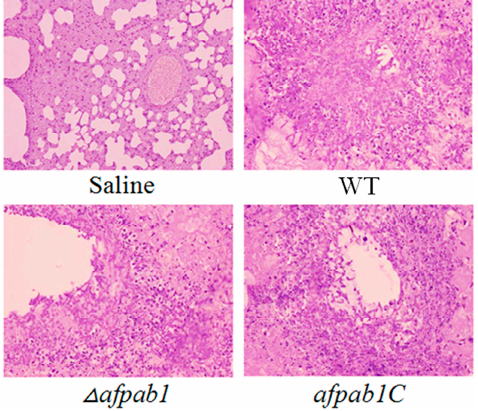
Figure 12. Lung sections from the dead mice were Periodic acid-Schiff stained and photographed (100×). The result showed that the mice died of invasive aspergillosis.